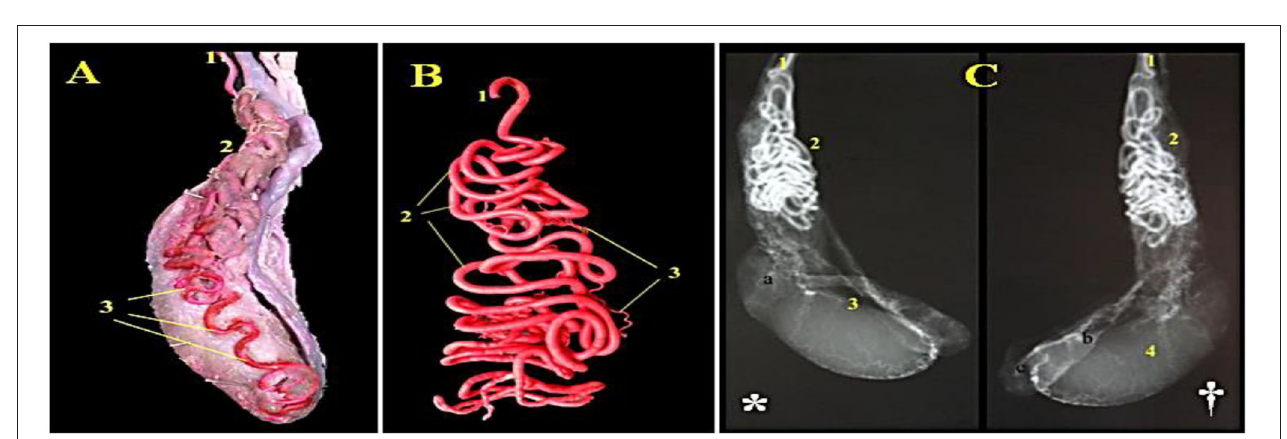
FIGURE 3 | A photograph of the camel’s right testis showing distribution of the testicular artery (Latex injection technique) is shown in (A) (1) A. testicularis, (2) Pars funicularis cum a. testicularis and (3) parsmarginalis cum A. Testicularis.A photograph of a corrosive arterial cast of the camel’s testis presented the convolutions of the testicular artery (Epoxy injection technique) is shown in (B) (1) A. testicularis, (2) Arterial windings and (3) Rami funicularis. A radiograph of camel’s testis showing distribution of the testicular artery injected with urographine ( * : medial view, † : lateral view: Exposure factors were 75Cm. FFD, 30 KVP and 95 MAS) is shown in (C) ( a. Caput epididymidis, b. Corpus epididymidis, c. Cauda epididymidis ): (1) A. testicularis , (2) Pars funicularis cum a. testicularis , (3) Parsmarginalis cum a. testicularis , and (4) Tunica arteriosa testis